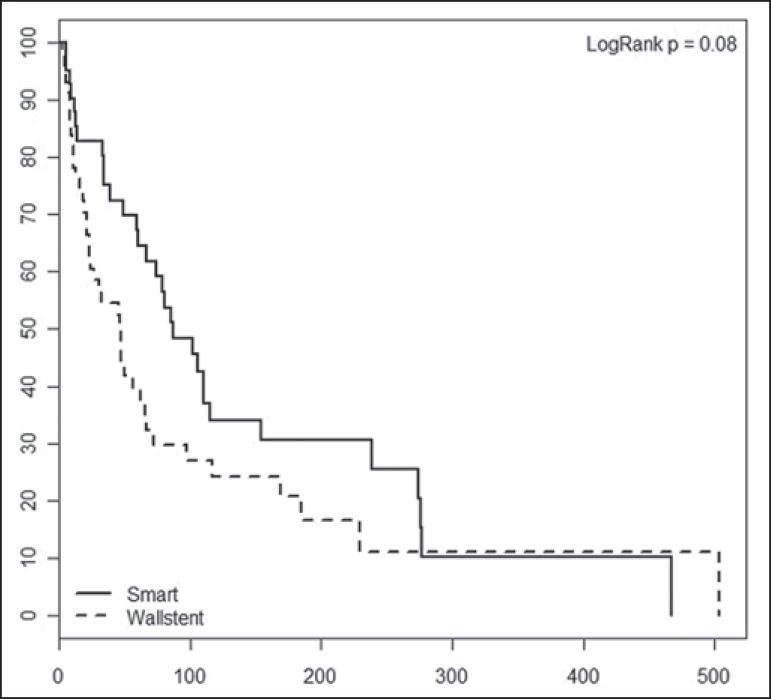
Occlusion-free survival curves according to the type of stent used
(Kaplan-Meier analysis with log-rank test).